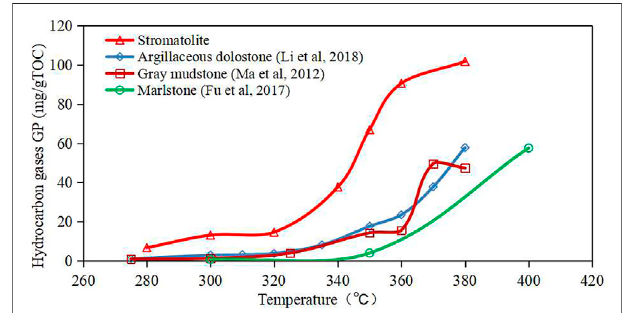
FIGURE 9 | Comparison of hydrocarbon gas generation